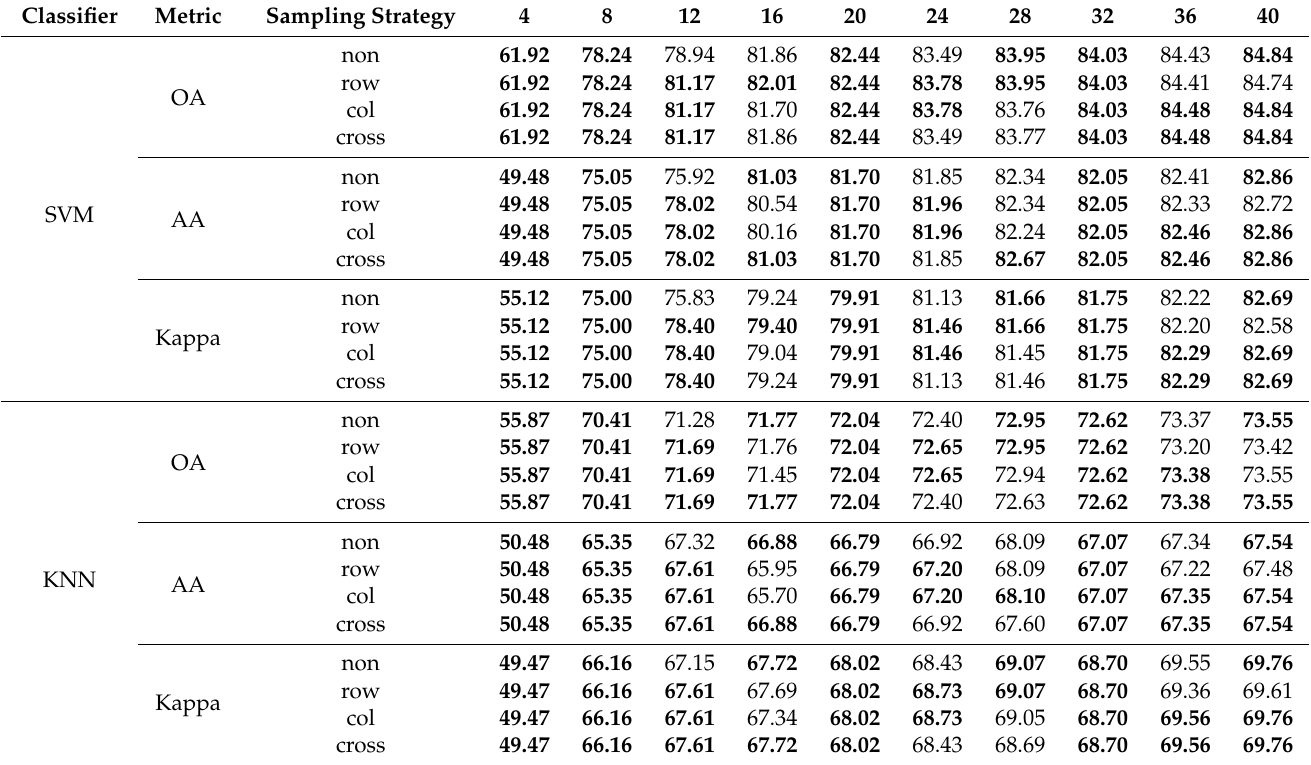
Table 1. Classification results of using different sampling strategies on the Indian Pines dataset.